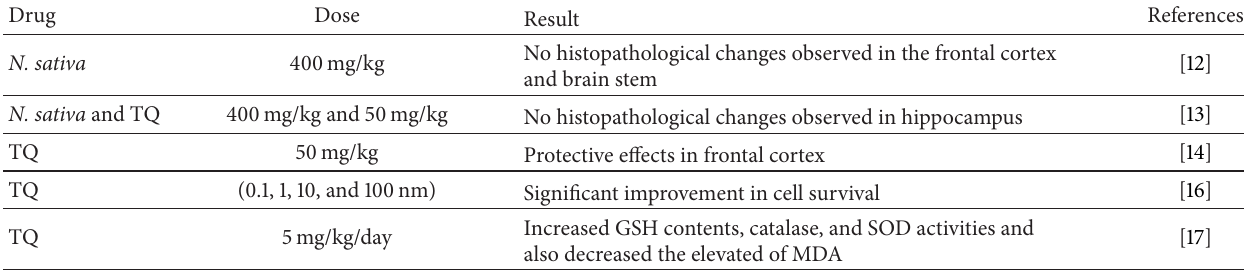
Table 2: The protective effect of Nigella sativa and its constituents on neurodegeneration and Alzheimer disease (AD). Drug